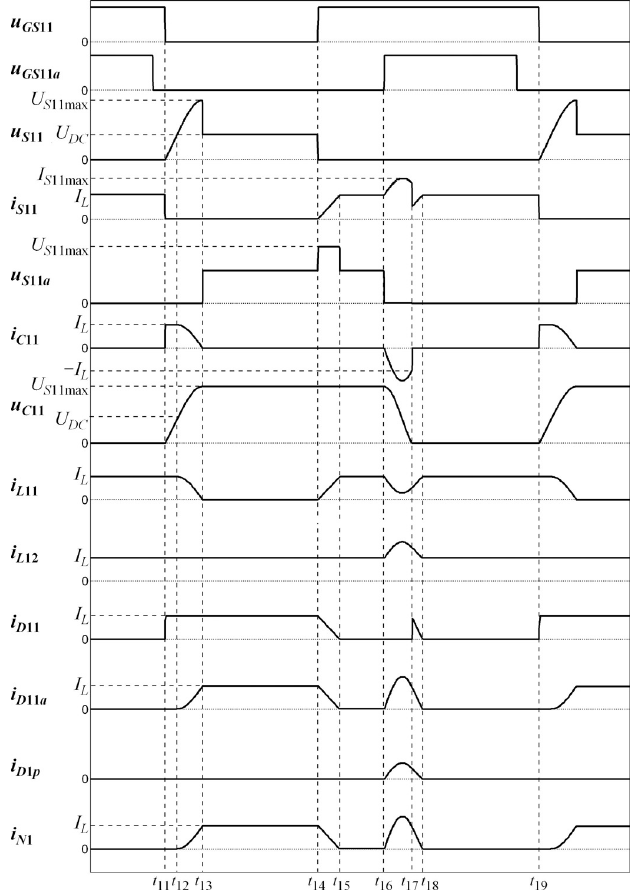
Figure 2. Simplified waveforms when S11 is switched ON/OFF: u GS 11 , u GS 11 a —control signals of switches S11 and S11a, respectively; i S 11 , u S 11 —current and voltage of switch S11, respectively; u S 11 a —voltage of switch S11a; i C 11 , u C 11 —current and voltage of capacitor C11, respectively; i L 11 , i L 12 —currents of inductors L11 and L12, respectively; i D 11 , i D 12 , i D 1 p —current of diodes D11, D12, D1p, respectively; i N 1 —neutral conductor current; I L —load current.